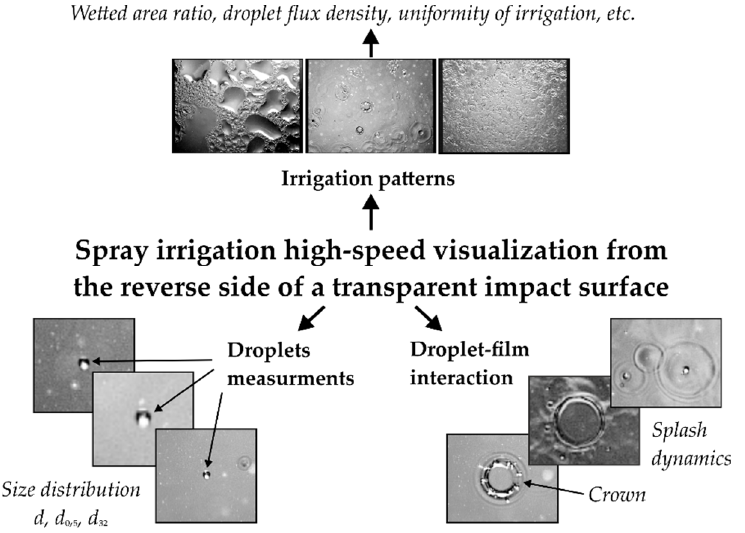
Figure 3. Prospects of using a transparent impact surface for studying the hydrodynamic parameters of spray irrigation.